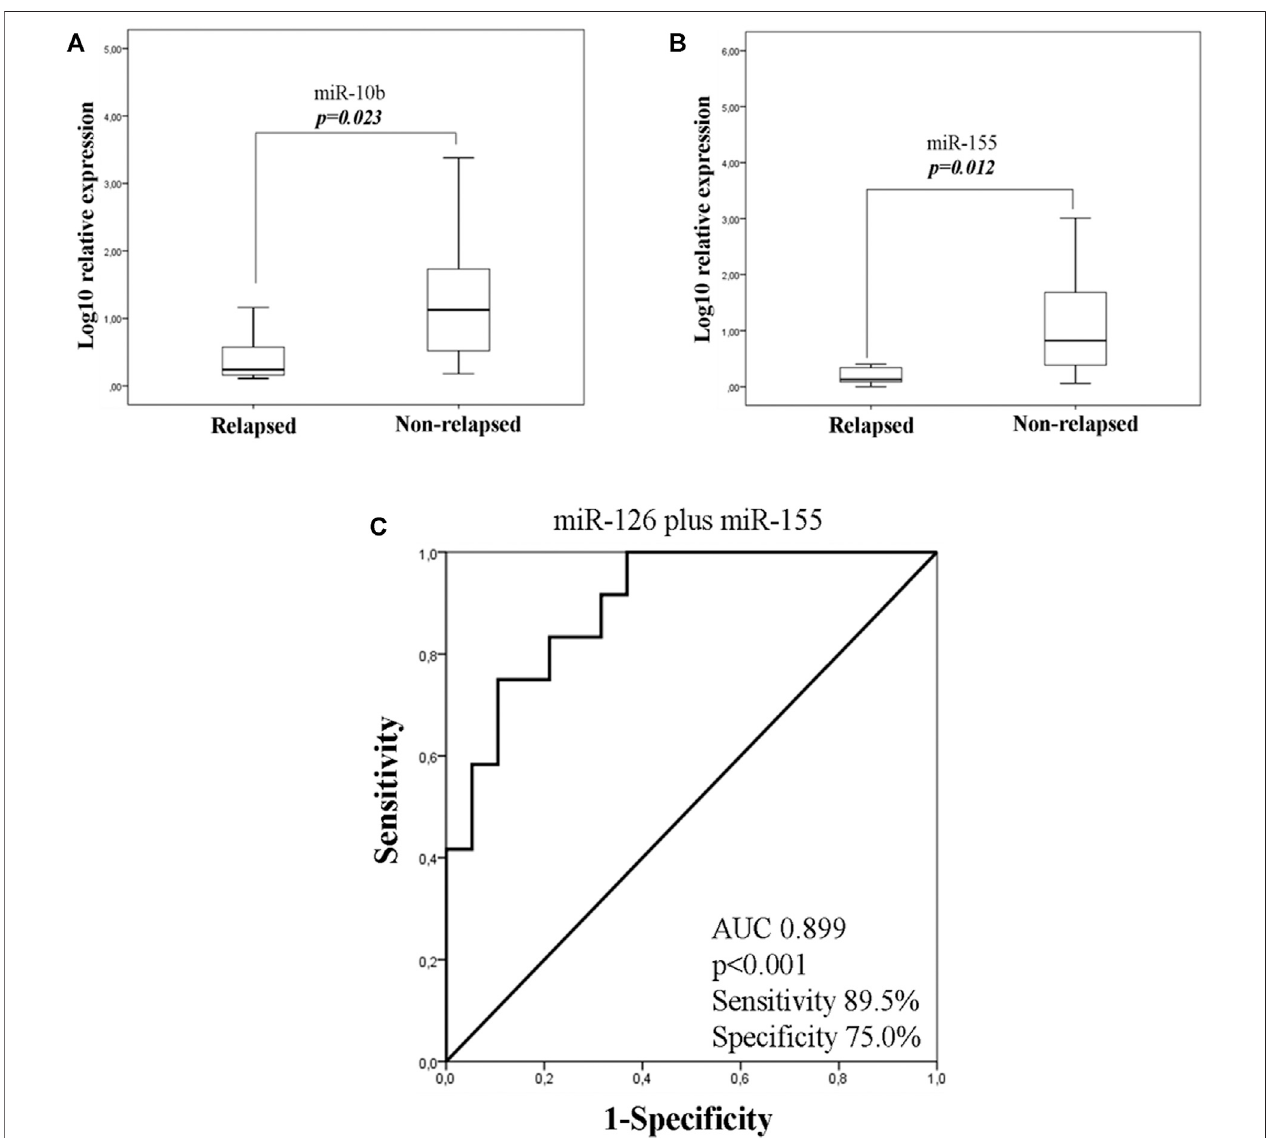
FIGURE 6 | Fold change of miR-10b (A) and miR-155 (B) in the plasma of TNBC according to relapse status. (C) . ROC curve analysis depicting the ability of 2- miRNApanelconsistedofmiR-126andmiR-155expressiontopredictrelapsedfromnon-relapsedpatientsintoTNBCsub-group.TNBC,triplenegativebreastcancer; AUC, area under